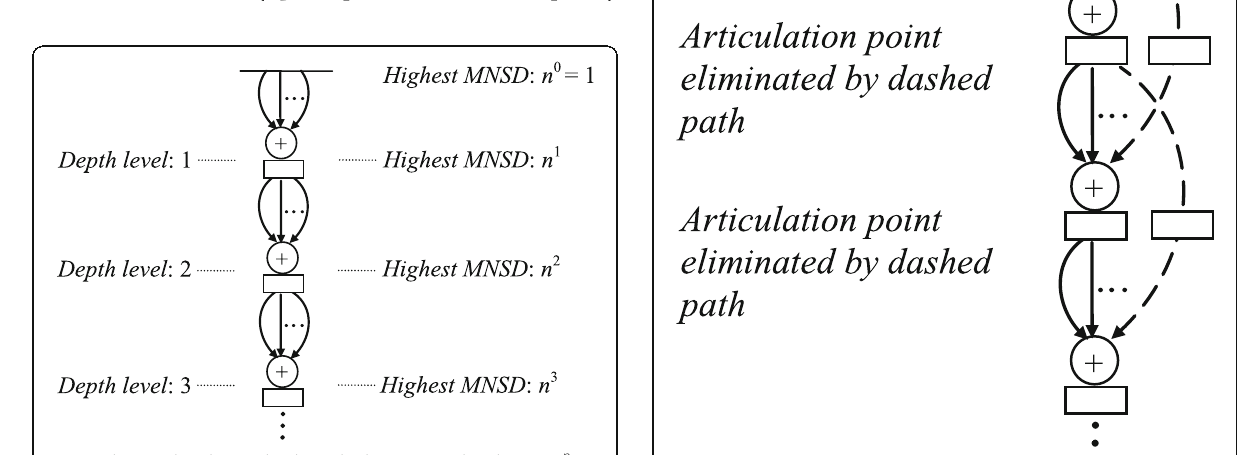
Fig. 7 The pipelined completely multiplicative graph achieves n p